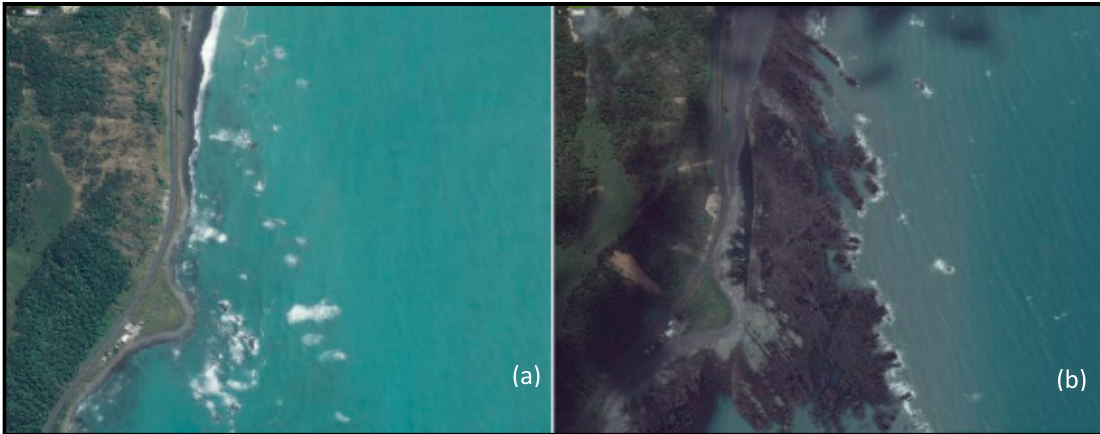
Figure 10. Waipapa Bay’s shoreline changes ( a ) before ( b ) and after tsunami captured by WorldView-2 images. (Source: http://info.geonet.org.nz).